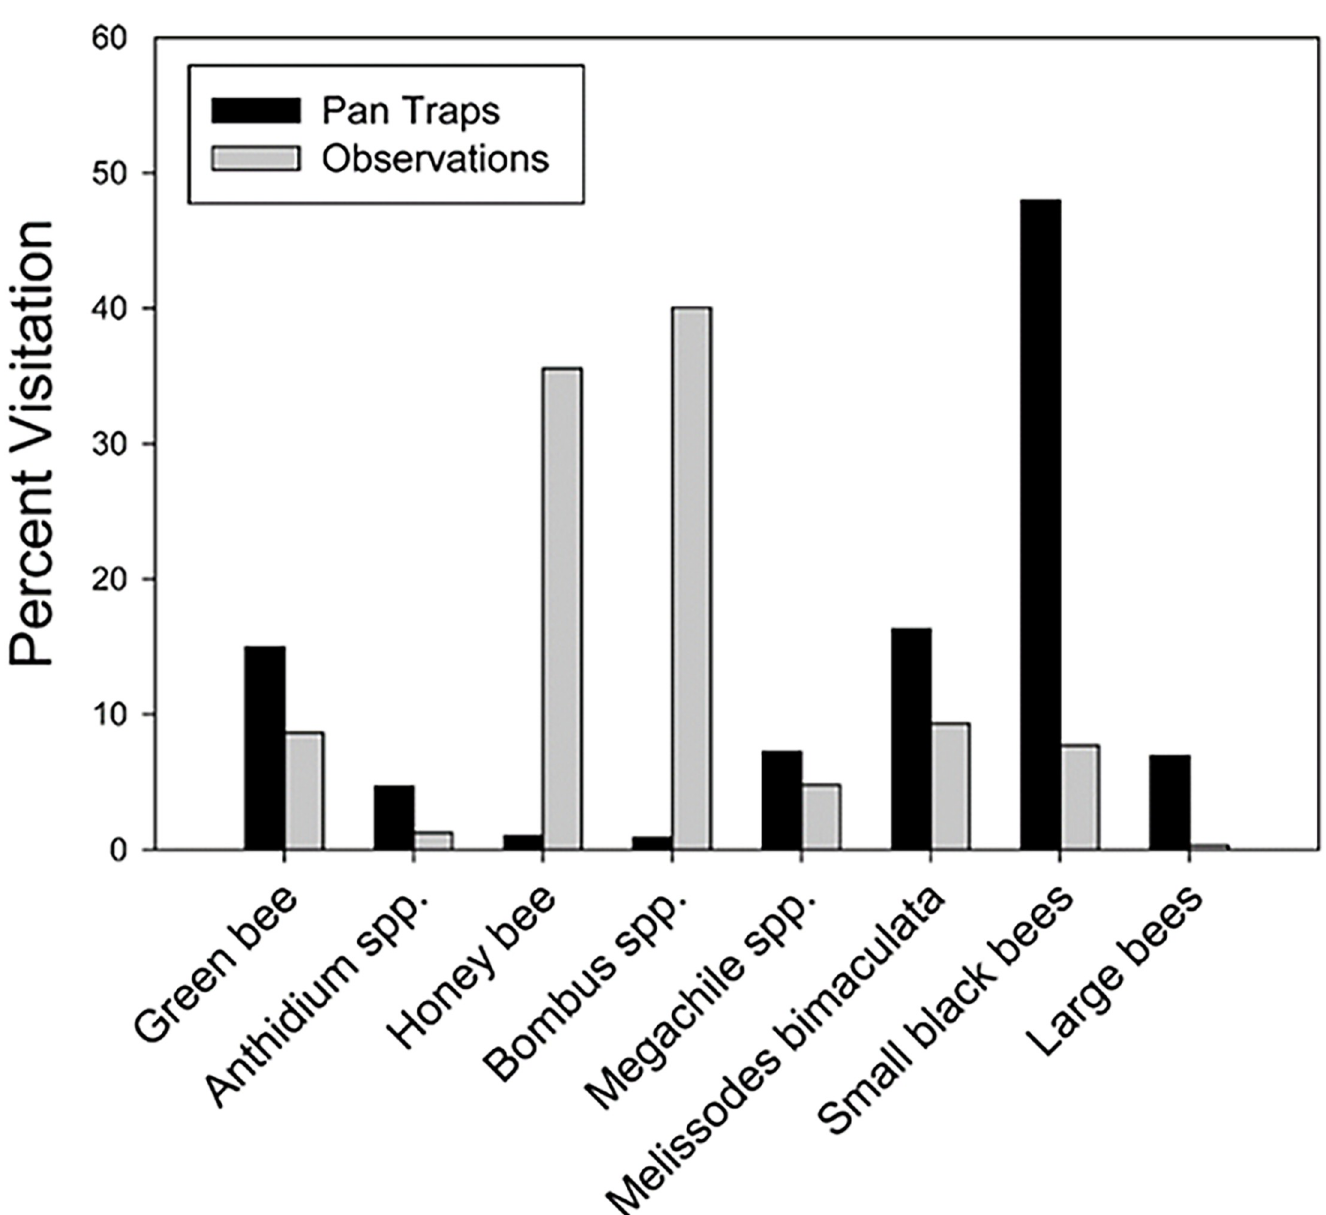
Fig 1. Percent visitation of bee groups. Percent visitation of bee groups were collected at 19 urban agricultural sites using pan traps (black bars) and visually observed (gray bars) visiting cucumber flowers during 2011.